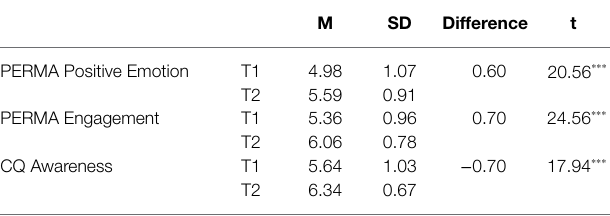
TABLE 5 | Paired samples test differences for wellbeing and cultural intelligence. M